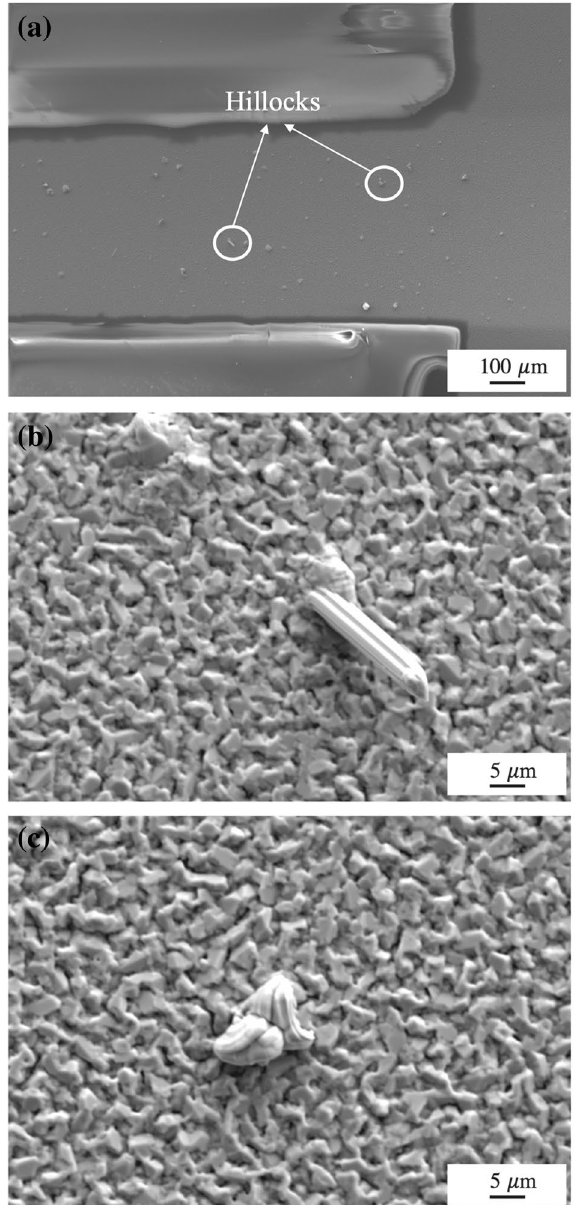
Figure 3. Morphology of the anode after uninterrupted EM for 650 h ( a ) Overall morphology, ( b ) and ( c ) Hillocks generated in the